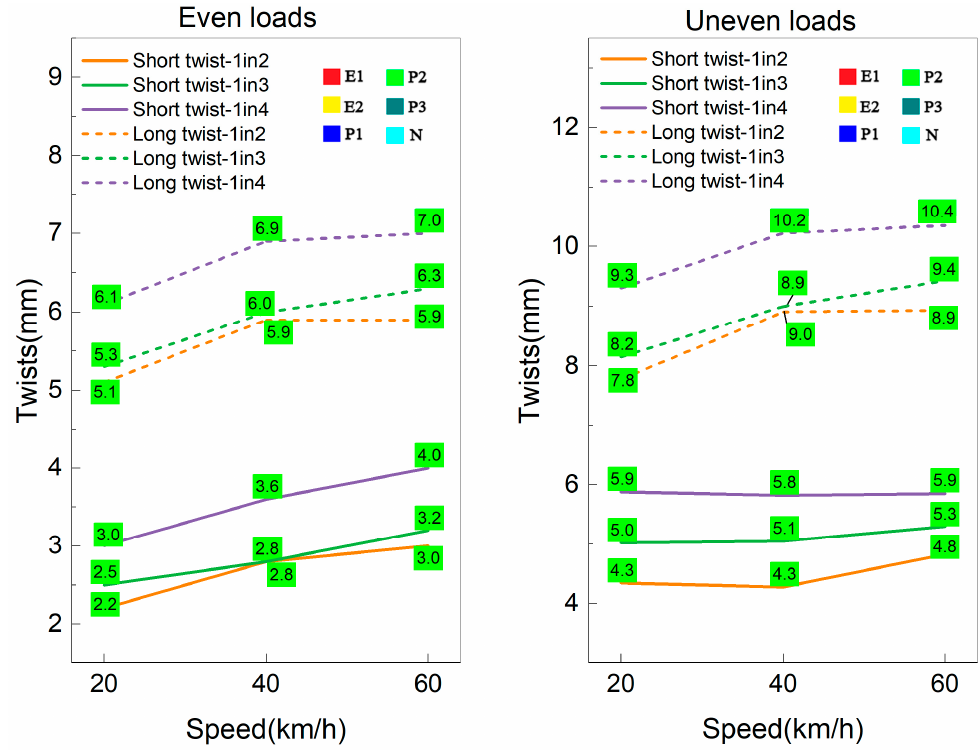
Figure 13. Dynamic twists of 1in2, 1in3 and 1in4 interspersed tracks under small-scale loss support and different load conditions.